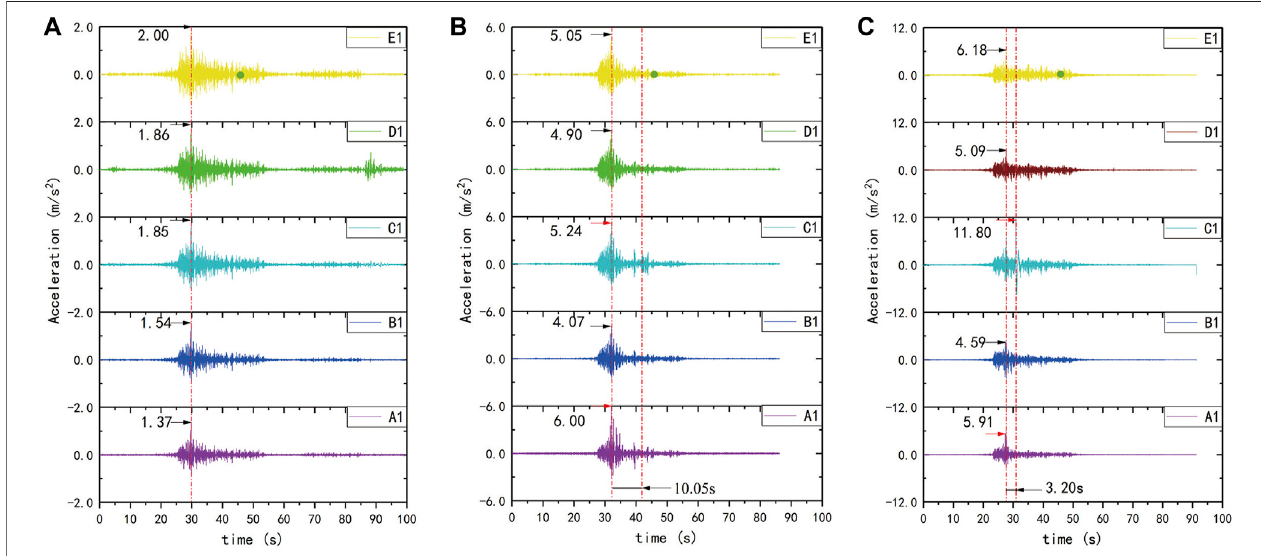
FIGURE 4 | The acceleration time history of the slope surface. (A) The input amplitude is 113 gal. (B) The input amplitude is 339 gal. (C) The input amplitude is 565 gal.